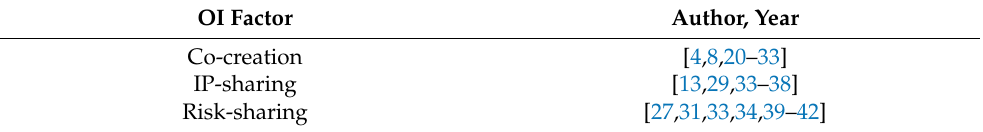
Table 2. OI factors.